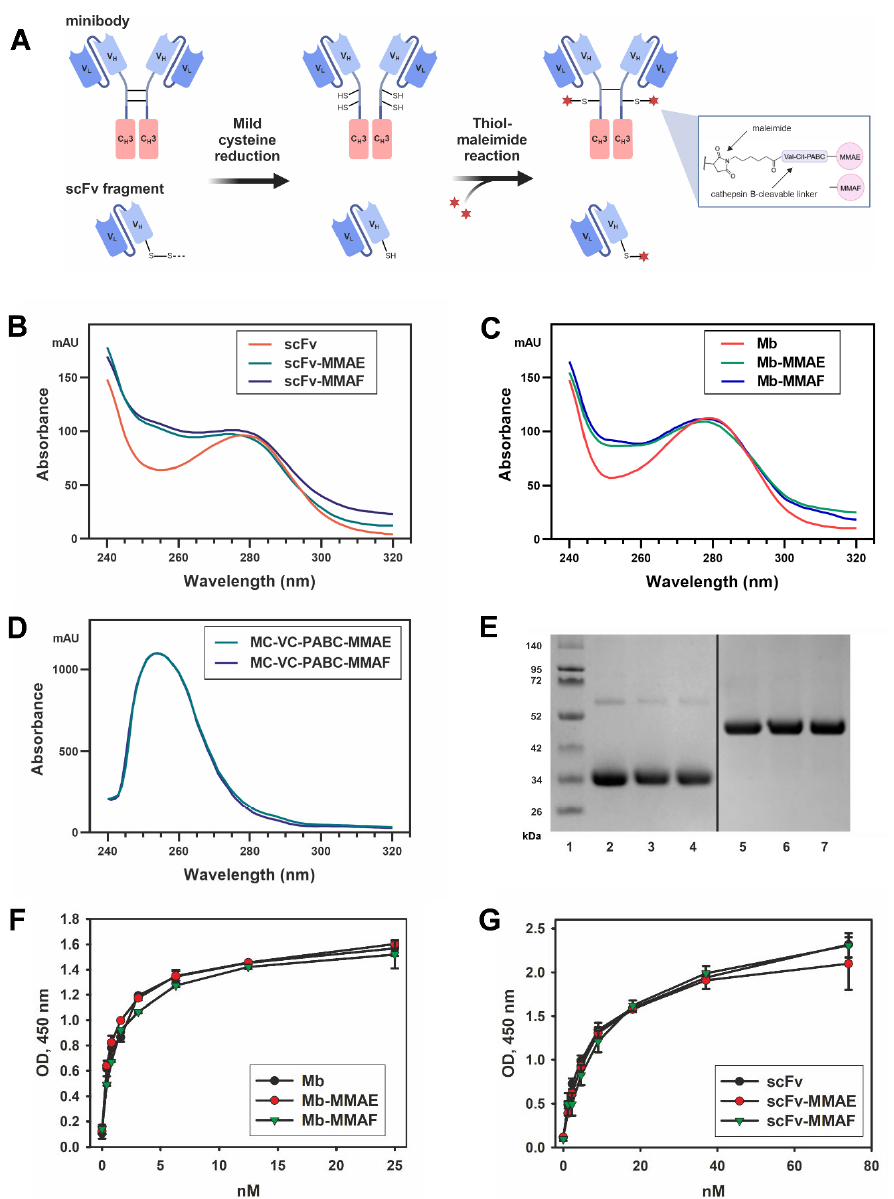
Figure 3. Production of the FDCs and analysis of their antigen ‐ binding properties. ( A ) Reaction scheme of the generation of scFv and minibody conjugates with MMAE and MMAF. ( B ) Absorption spectra of the scFv ‐ based FDCs normalized at 280 nm. ( C ) Absorption spectra of the minibody ‐ based FDCs normalized at 280 nm. ( D ) Absorption spectra of the auristatin drugs used for conjugation. ( E ) Polyacrylamide gel electrophoresis of the FDCs in reducing conditions, 5 min incubation at 95 °C. 1, molecular weight protein markers; 2, scFv; 3, scFv ‐ MMAE; 4, scFv ‐ MMAF; 5, minibody; 6, minibody ‐ MMAE; 7, minibody ‐ MMAF. ( F ) Direct ELISA of minibodies and minibody ‐ based FDCs; ganglioside GD2 was adsorbed on the plate, serial dilutions of scFv fragments were added to the wells; after incubation with HRP ‐ labeled anti ‐ human antibodies (1:6000), the reaction was developed by Ultra TMB ‐ ELISA Substrate Solution. Data are represented as mean ± SEM. ( G ) Direct ELISA of scFv fragments and scFv ‐ based FDCs; ganglioside GD2 was adsorbed on the plate, serial dilutions of scFv fragments were added to the wells; after incubation with HRP ‐ labeled anti ‐ FLAG antibodies (1:6000), the reaction was developed by Ultra TMB ‐ ELISA Substrate Solution. Data are represented as mean ± SEM. scFv–scFv fragments 14.18, Mb–minibodies 14.18.